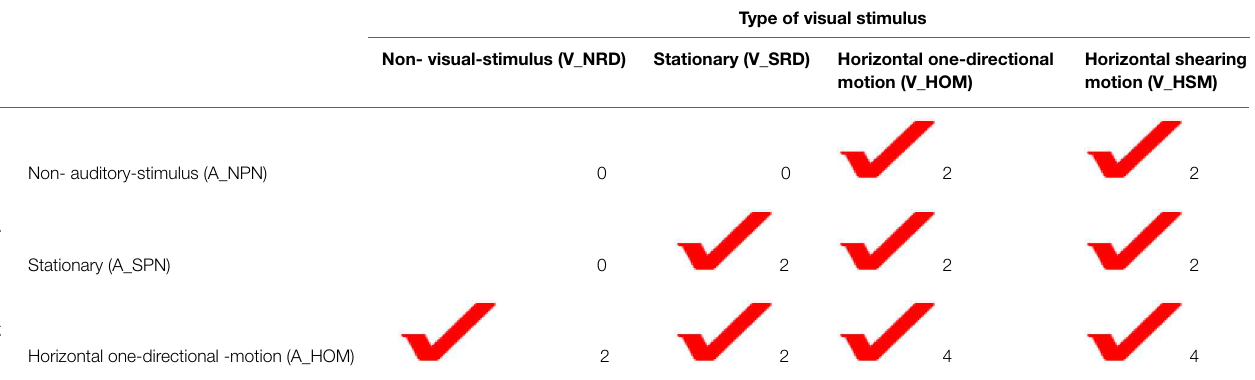
Type of visual stimulus